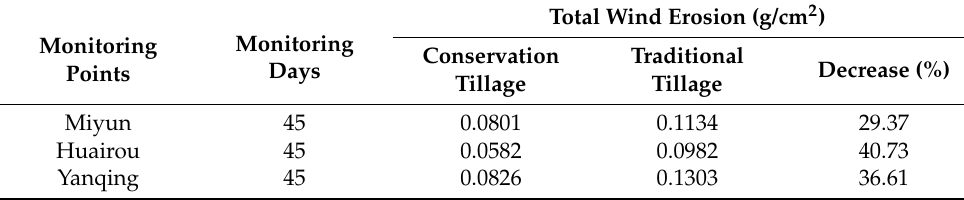
Table 2. Comparison of wind erosion monitoring results at monitoring points.